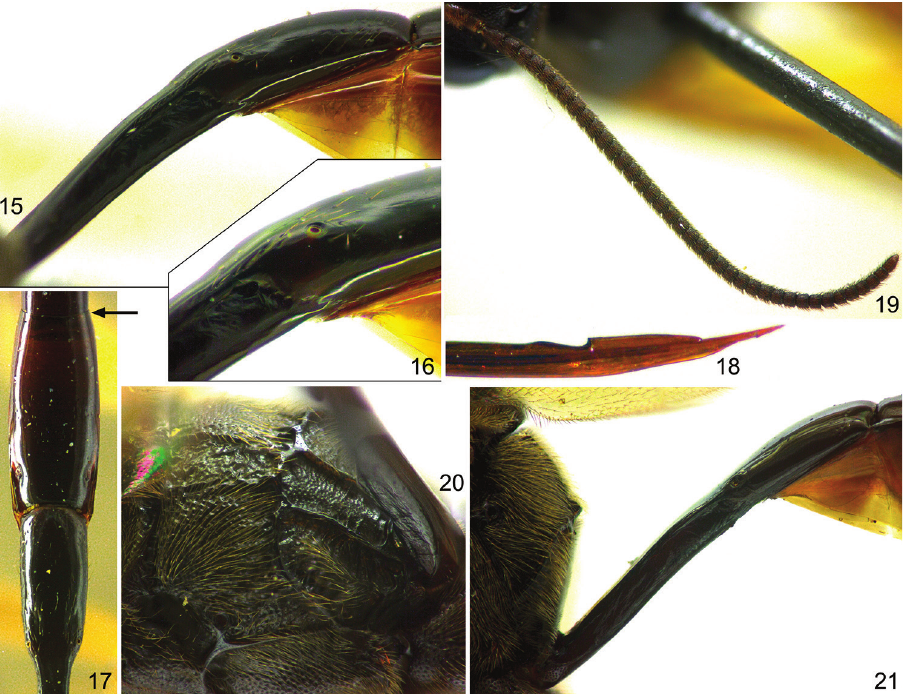
Figures 15–21. Stethantyx durrelli sp. n., female, holotype ( 15–18 ) and male, paratype ( 19–21 ): 15 first tergite, lateral view 16 glymma, lateral view 17 first and second tergites, dorsal view (the arrow points to the hind end of second tergite) 18 apex of ovipositor, lateral view 19 antenna, lateral view 20 propodeum, dorsolateral view 21 propodeum and first tergite, lateral